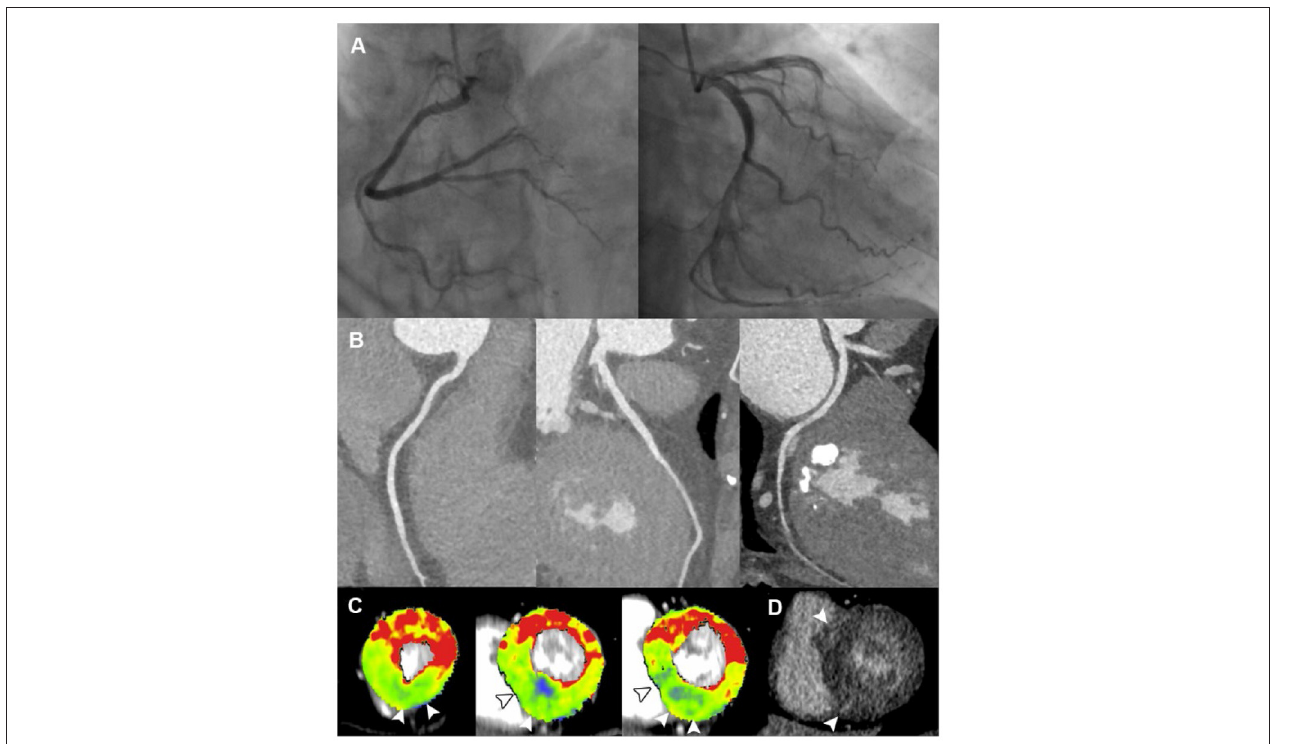
FIGURE 4 | Representative case of cardiomyopathy in a 60-year-old female with ACS and non-obstructive ICA. (A,B) ICA and CCTA revealed normal coronary vasculature. (C) Short-axis views of CT-MPI showed significantly reduced myocardial blood flow at apical inferior, mid septal, mid inferior, basal septal as well as basal inferior segments, with focal myocardial hypertrophy (white arrowhead). (D) LIE image showed the focal intra-mural late enhancement at RV insertion points (white arrowhead). The above findings were consistent with the diagnosis of hypertrophic cardiomyopathy. ACS, acute coronary syndrome; CCTA, coronary computed tomography angiography; CT, computed tomography; ICA, invasive coronary angiography; LAD, left anterior descending; LAP, low-attenuation plaque; LIE, late iodine enhancement; MPI, myocardial perfusion imaging; MVO, microvascular obstruction; RV, right